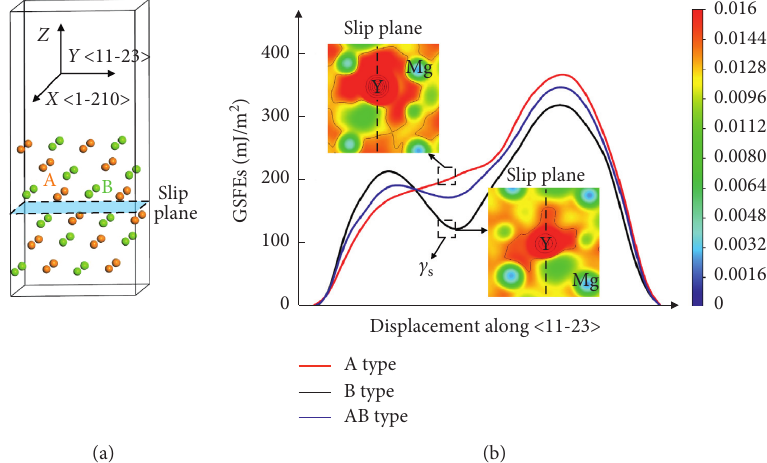
Figure 1: (a) Slab supercell of 1011 􏼈 􏼉 1123 slip system of Mg. Orange and green spheres indicate basal type A and type B atoms, respectively. (b) The distributions of charge densities on the 0.4b positions in the generalized stacking fault energy (GSFE) curves on the 1011 􏼈 􏼉 planes of Mg-Y alloys. Red (blue) region denotes the area with high (low) charge density. Contour lines are drawn at a constant interval. Note that the GSFE curves are taken from our recent work [15], wherein the stable stacking fault energy is denoted as c S , which is related to the dissociation of 〈 c + a 〉 dislocation.